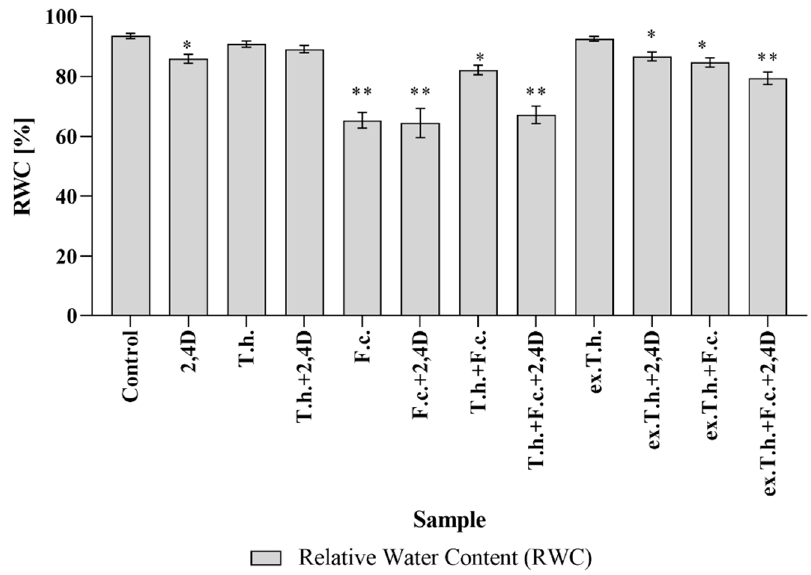
Figure 2. The RWC values of the shoot seedlings measured after 7 days of cultivation (T.h.— T. harzianum -inoculated wheat seeds; F.c.— F. culmorum -inoculated wheat seeds; ex.T.h.— T. harzianum extracellular metabolite-treated wheat seeds). Data represent means ± SE; the significance of the variance study with Tukey’s post hoc test = * p ≤ 0.001, ** p ≤ 0.0001. The subcolumn statistic comparison is attached in supplementary material as Table S2.